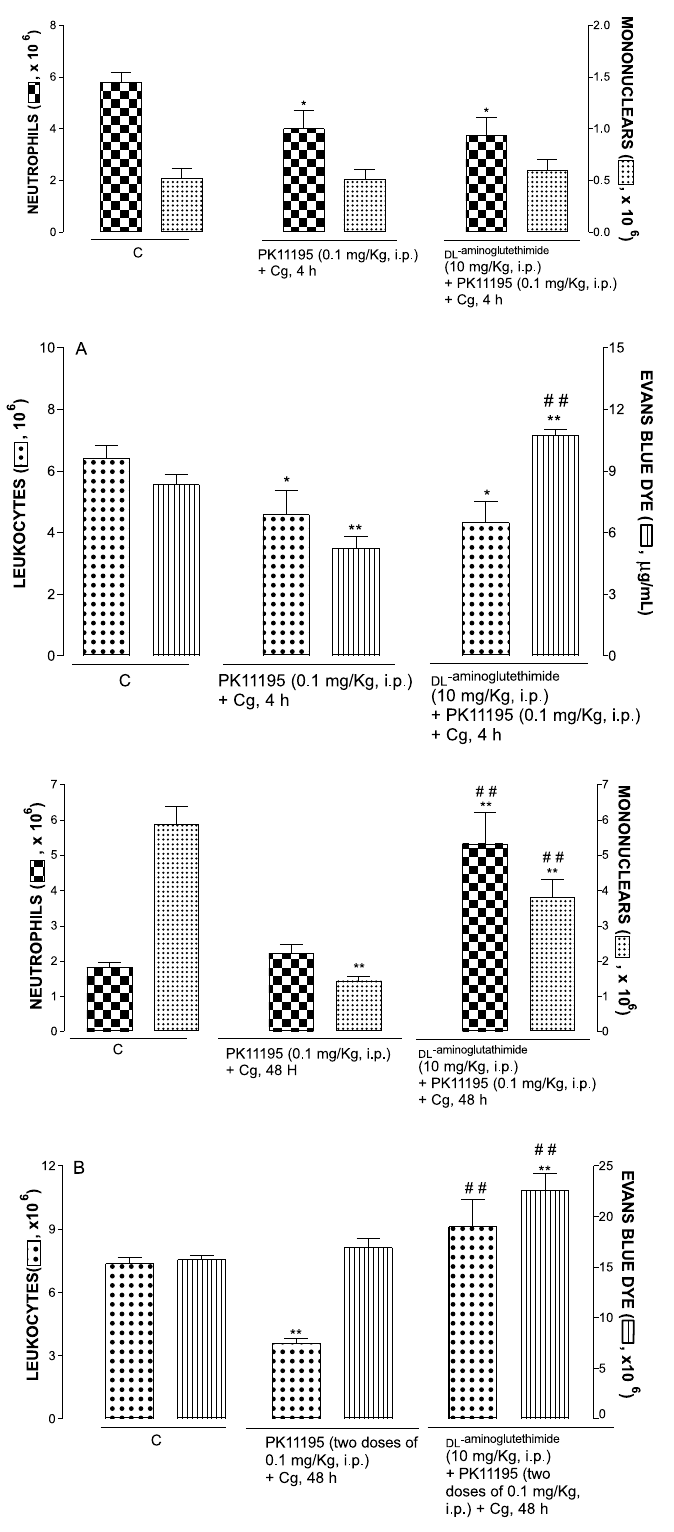
FIG. 4. Effects of D,L -aminogluthetimide and PK11195 association on early (4 h) or late (48 h) phases of the mouse pleurisy induced by carrageenan (Cg, 1%/cav.). The animals were pre-treated (0.5 h) with D,L -aminogluthetimide (10 mg/kg, i.p.) before PK11195 (0.1 mg/kg, i.p.) and then mouse pleurisy was induced by Cg. (A) Leukocytes and exudation levels in the early (4 h) phase of the inflammatory response. (B) Leukocytes and exudation levels in the late (48 h) phase of the inflammatory process. Insets: Mononuclear and neutrophil cells, under the same conditions. C, Control responses in animals only treated with Cg. Each column represents the mean of four to six animals, and the vertical bars represent the standard error of the mean. * p B / 0.05 and ** p B / 0.01, Cg versus PK11195; # # p B / 0.01, PK11195 versus D,L -aminoglutethimide plus PK 11195. Mediators of Inflammation (cid:1) Vol 13 (cid:1)